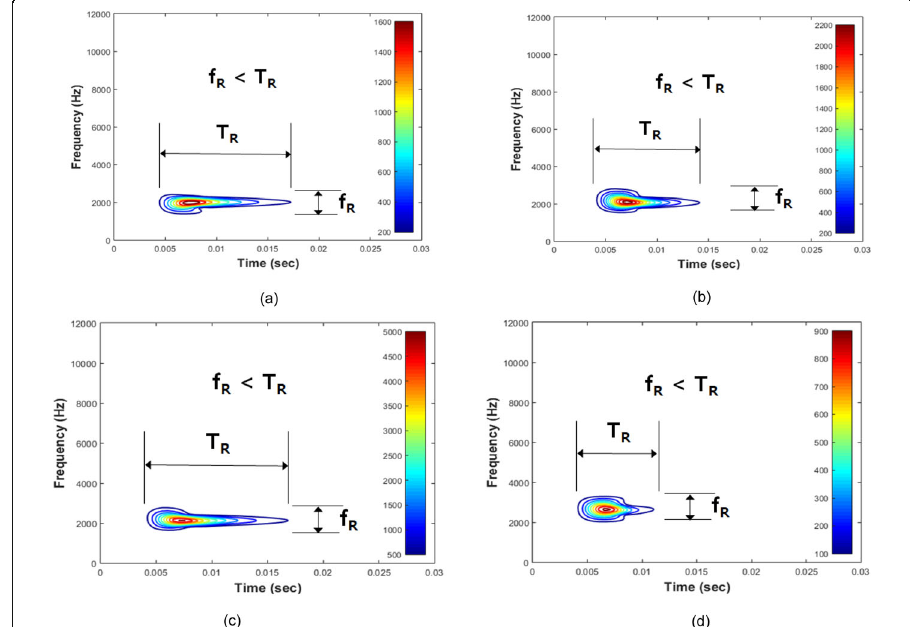
Table 1 Comparison of the measured depth and the calculated gap depth No Cavity Size (mm) TCL Thickness (mm) Calculation